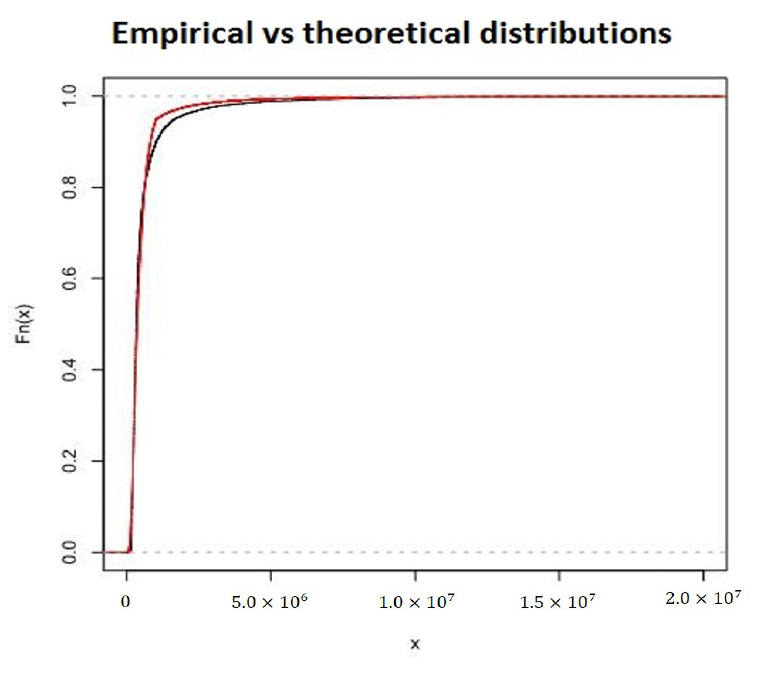
Figure 7. Lognormal–GPD (red) and empirical (dark) distribution